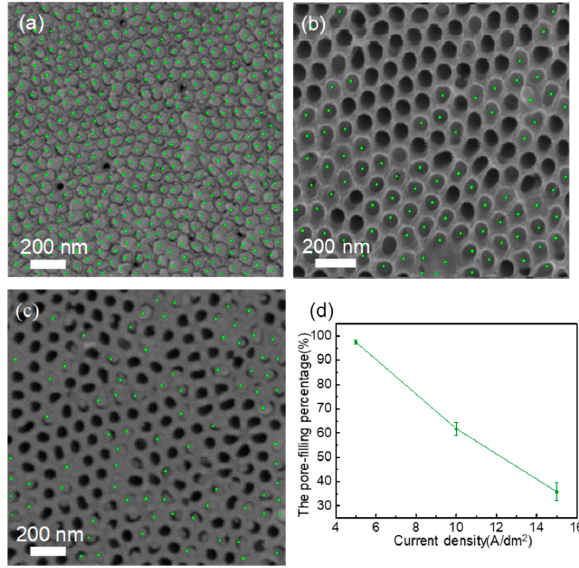
Figure 3. Top-view of copper nano-pillars (CNPs) filled in AAO interposer with different electric current densities with 8 h: ( a ) 5 A/dm 2 ; ( b )10 A/dm 2 ; ( c )15 A/dm 2 and ( d ) the relationship of the pore-filling percentage versus current density.